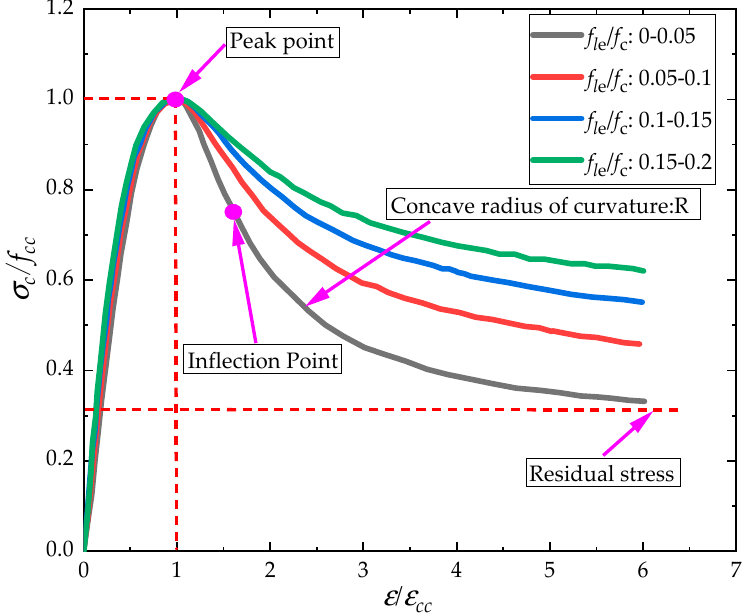
Figure 11. Effect of different lateral confinement ratios on the geometry of the complete curve. There are different functional forms of the complete curve equation for the stress– strain relationship of the confined concrete. It can be mainly divided into segmental non- derivative and continuous derivative functions based on the derivability of the function; in this study, based on the reference of existing models, the continuous derivative function form is suggested, and the expression is